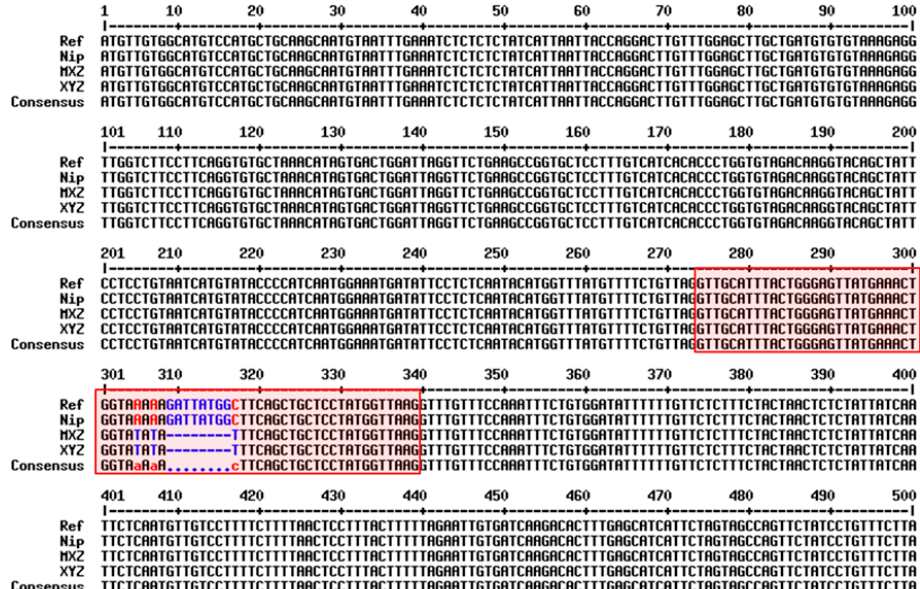
Figure 2. Partial of the BADH2 gene sequence alignments in studied genotypes. Reference sequences; NiP: Nipponbare; MXZ: Meixiangzhan2; XYZ: Xiangyaxiangzhan. The red box depicts the seventh exon; The blue color depicts the 8 bases are different; The red color depicts one SNP is